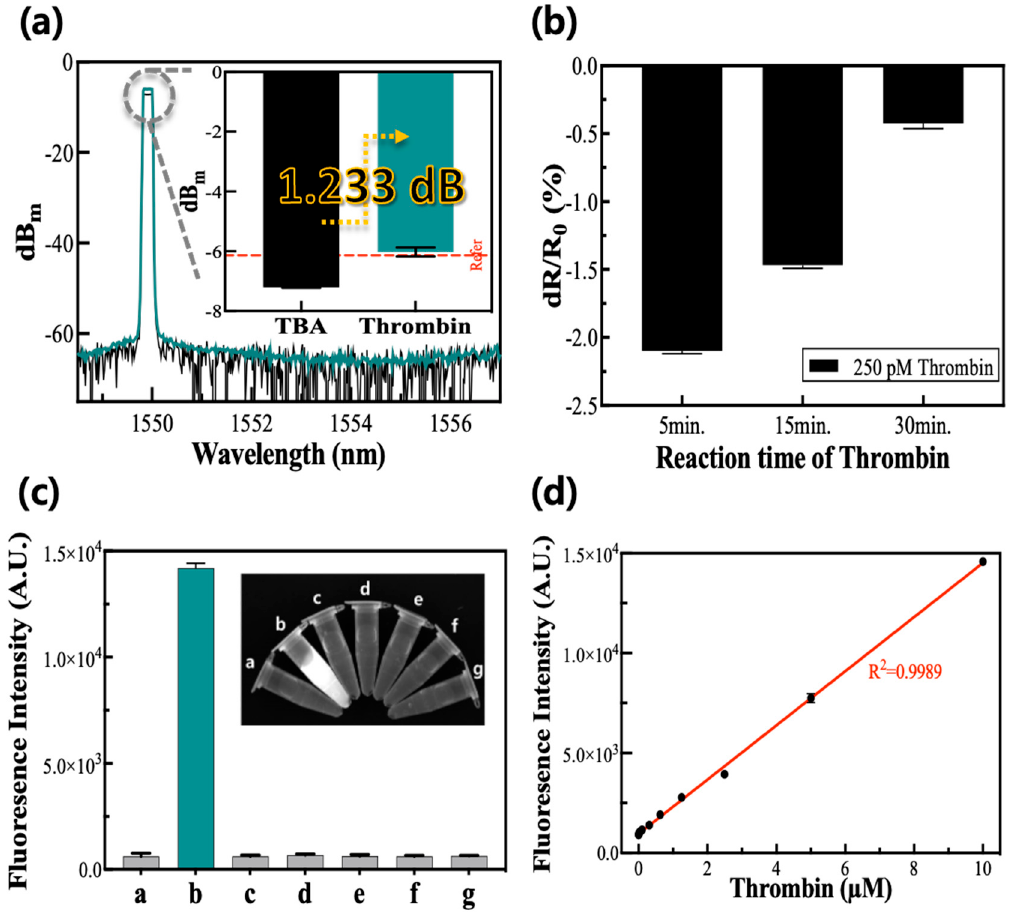
Figure 3. Detection of thrombin via mechanical, electric, and optical methods. ( a ) Mechanical analysis before and after the addition of thrombin on the aptamer that adhere to substrate. ( b ) Electrical analysis resistance change rate according to the reaction time of thrombin. ( c ) Optical analysis for the selectivity of the TBA-FAM/GO-based system. The letters (a–g) of the graph and inset picture represent the blank, thrombin, GOx, IgG, trypsin, lysozyme, and ficin. ( d ) The corresponding calibration plot to ( c ) shows the fluorescence intensity versus thrombin concentration. The SD value after thrombin reaction in ( a ) was about 0.152. In ( b ), the SD values increased over time from 0.020 to 0.038. The coefficient of variation of the experimental results in ( d ) has an average value of 0.028 ( ±